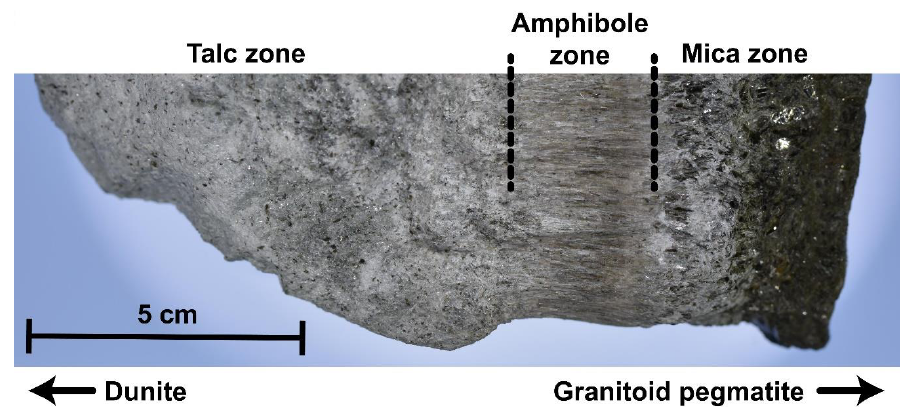
Figure 4. From right to left: trondhjemitic pegmatite (not visible), proximal mica zone, fibrous white amphibole zone (anthophyllite), talc-dominated zone, dunite (not visible), which is the dominant rock type of the Seqi Ultramafic Complex.